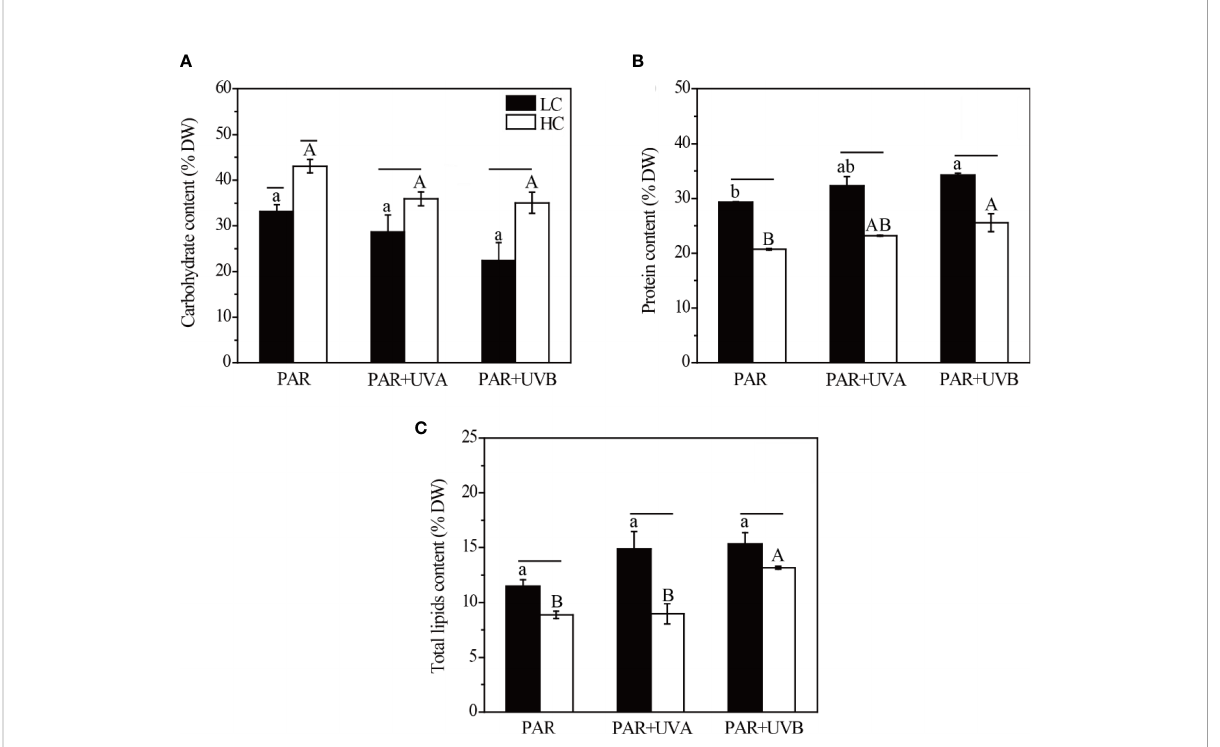
FIGURE 5 The carbohydrate (A) , protein (B) and total lipids (C) contents of Rhodosorus sp. SCSIO-45730 treated under different p CO 2 levels and UVR. Short horizontal lines represent signi fi cant differences (P<0.05) among CO 2 treatments at the same UVR treatment, while long horizontal lines indicate insigni fi cant differences. Different lowercase letters represent signi fi cant differences (P<0.05) among UVR treatments under LC, and different capital letters indicate signi fi cant differences (P<0.05) among UVR treatments under